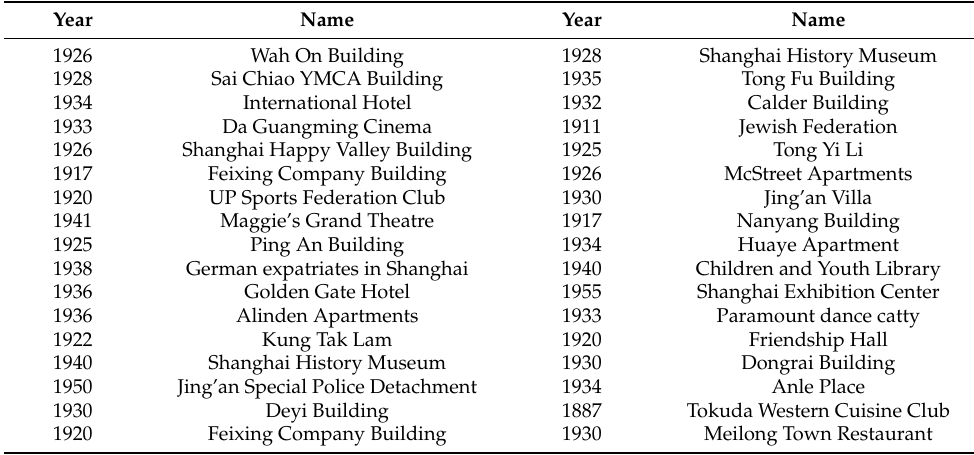
Table 1. Outstanding Historic Buildings and Years